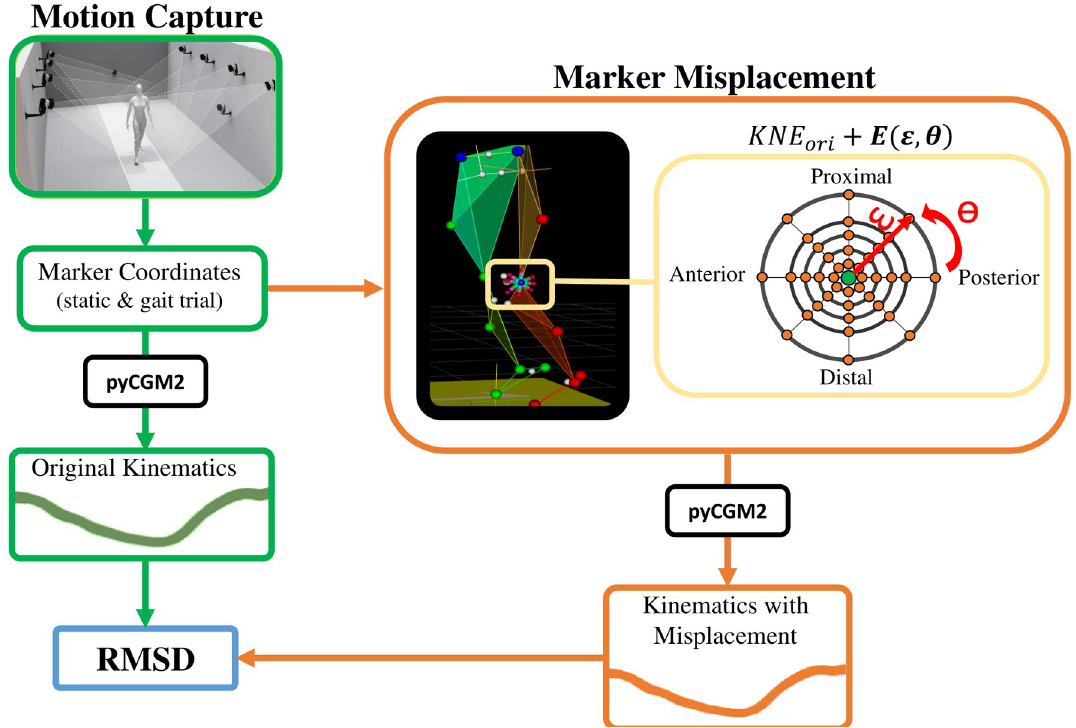
Fig 1. Workflow for sensitivity analysis. From gait measurement, one static and one gait trial were considered. The original marker set was used to calculate the reference kinematics (green path). Coordinates of KNE marker were systematically misplaced as a function of angle direction ( θ ) and magnitude ( ε ) and the kinematics was calculated for each misplacement (orange path). Finally, the RMSD was calculated as a function of each misplacement kinematics (Err i ) and the reference kinematics (O i ) (grey).